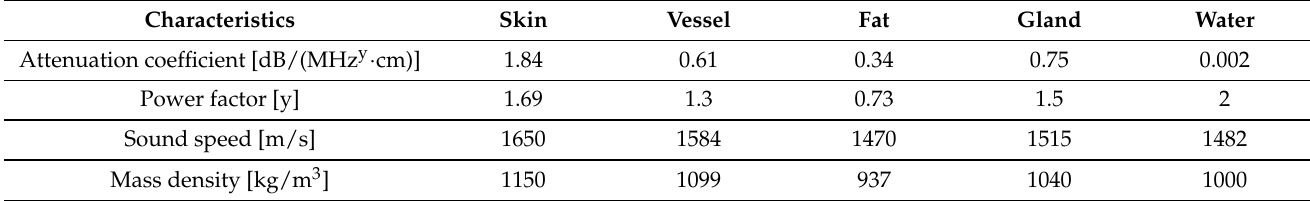
Figure 1. ( a ) Three-dimensional mean projected breast (projected on the xz plane with pixel values corresponding to the skin, fat, fibroglandular, and blood vessels of 204, 153, 102, and 255, respectively, on the scale of 0–255). ( b ) Two-dimensional cross-section image (parallel to the xy plane) taken roughly from the midpoint of the breast [34,35]. Table 1. Acoustic parameters corresponding to various parts of breast tissues (skin, blood vessels, fat, and glands) and the surrounding water employed in simulation for HIFU wave propagation